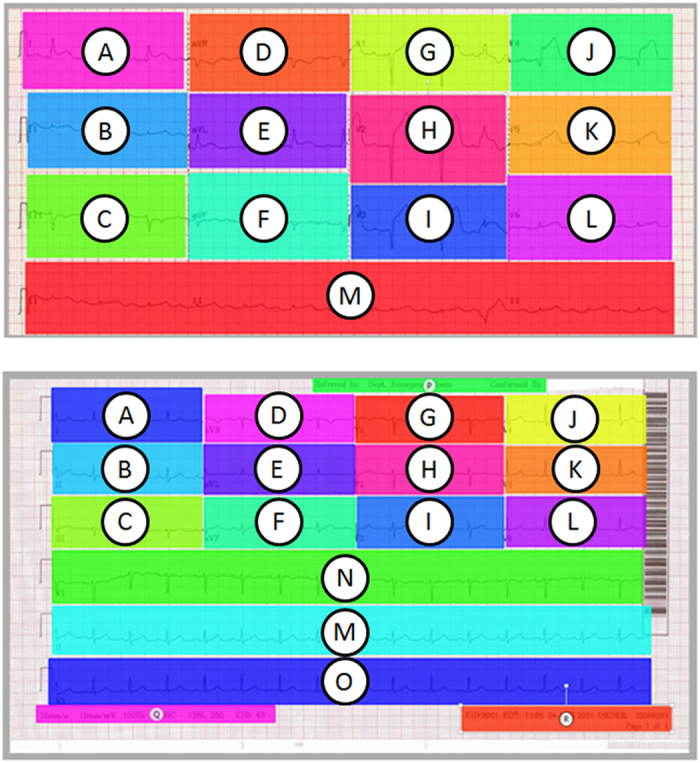
Layout types.Top: (A) bottom (B) Equation 1. Jensen-Shannon Distance.